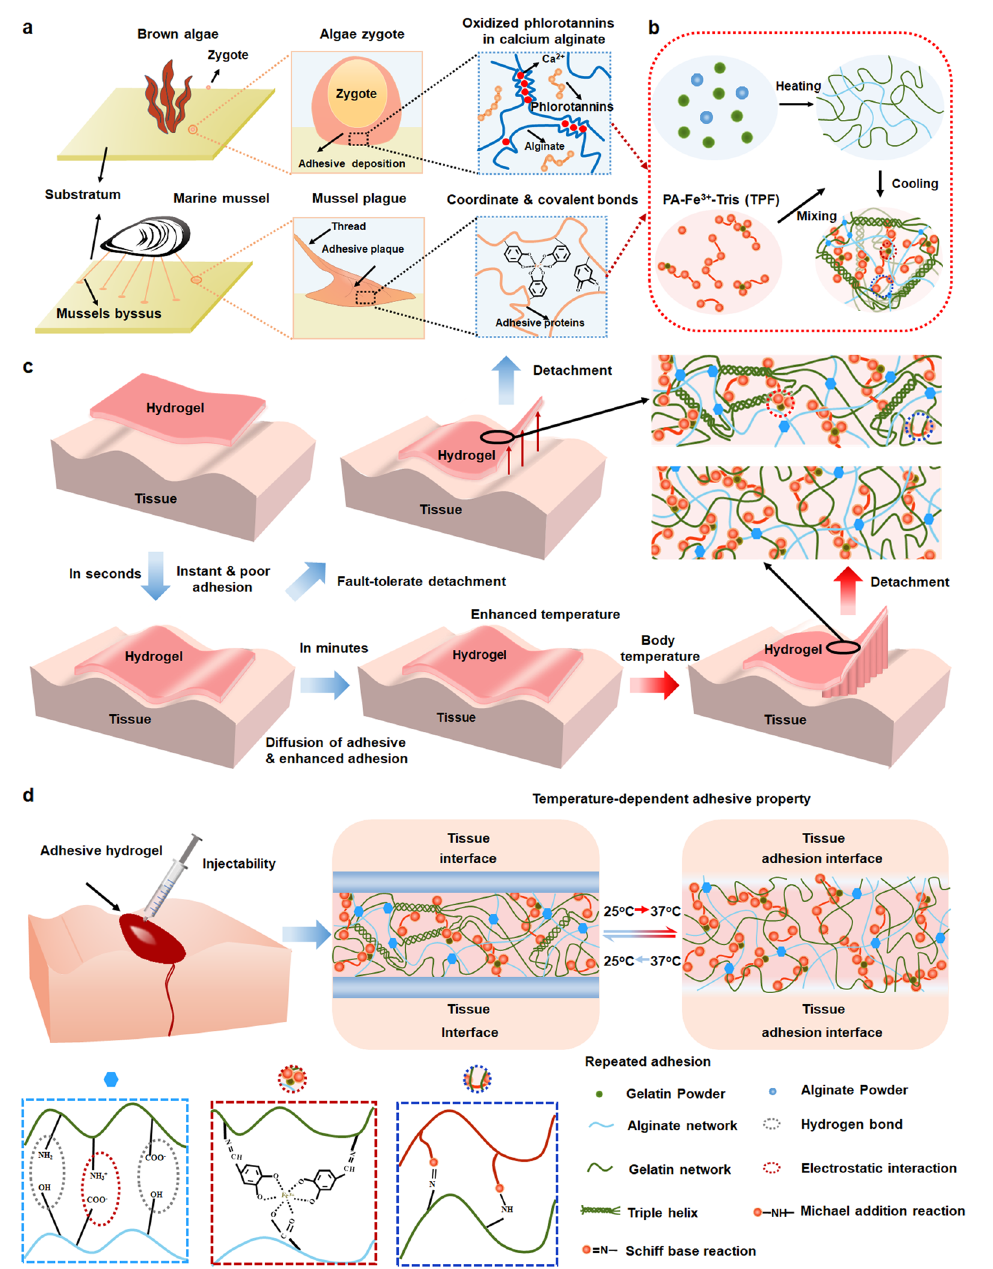
Fig. 1 The schematic representations of the fault-tolerate detachment and temperature-responsive adhesive properties of the bioinspired adhe- sive hydrogel as tissue sealant. a Components of brown algae adhesives and marine mussel adhesives. b Schematic representations for the prep- aration of the bioinspired adhesive hydrogel. c The illustration for the fault-tolerate detachment of the hydrogel. The temperature-dependent adhesion is originated from the improved segment mobility of the GT due to the helix bundles in network transferred to random coils at body temperature, which increases the possibility of contact between the adhesives and the functional group. It might take several minutes for the tem- perature of the gel to warm up to body temperature, during which the mispositioning hydrogel could be removed and repositioned. d Schematic illustration for the temperature-dependent adhesive mechanism and repeated adhesion of the hydrogel as tissue